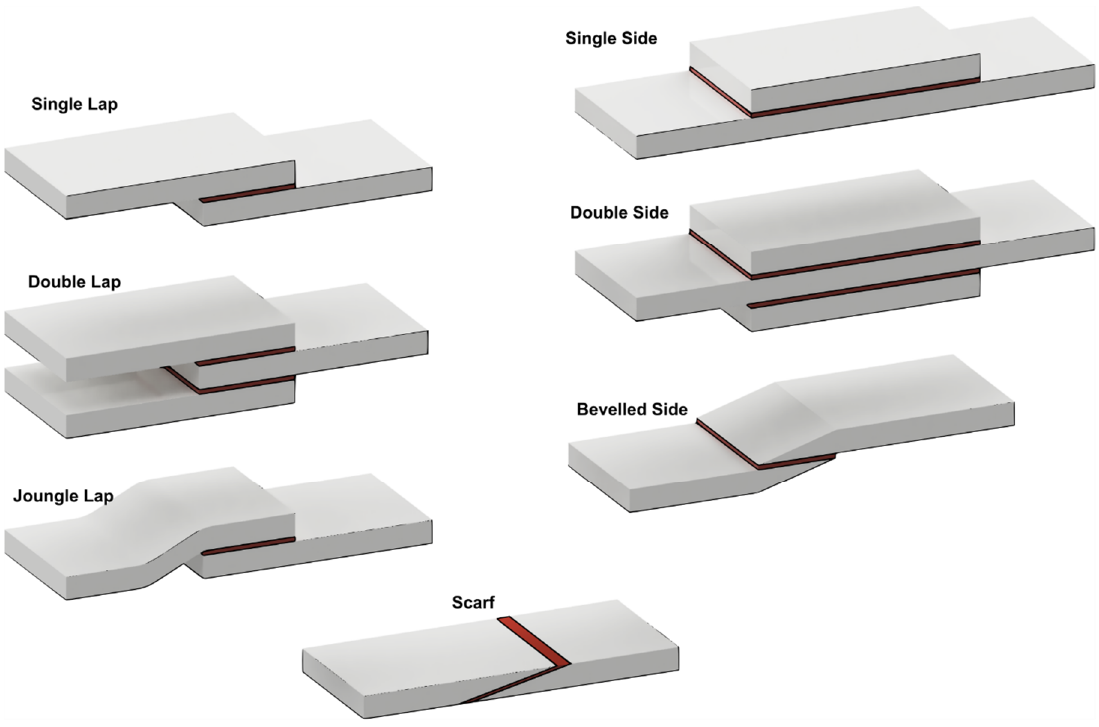
Figure 2. Typical sheets configurations used in adhesive bonding.